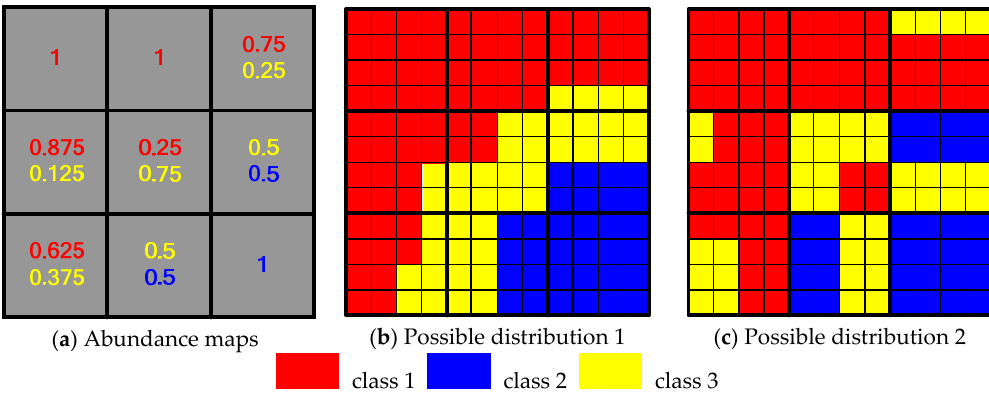
Figure 1. An example illustrating sub-pixel mapping methods. ( a ) Abundance maps are extracted for a 3 × 3-pixel image. ( b ) A possible distribution of sub-pixels in a finer resolution image in which a coarse pixel is divided into 16 (4 × 4) sub-pixels. ( c ) Another distribution perceived as less optimal than the one reported in ( b ).